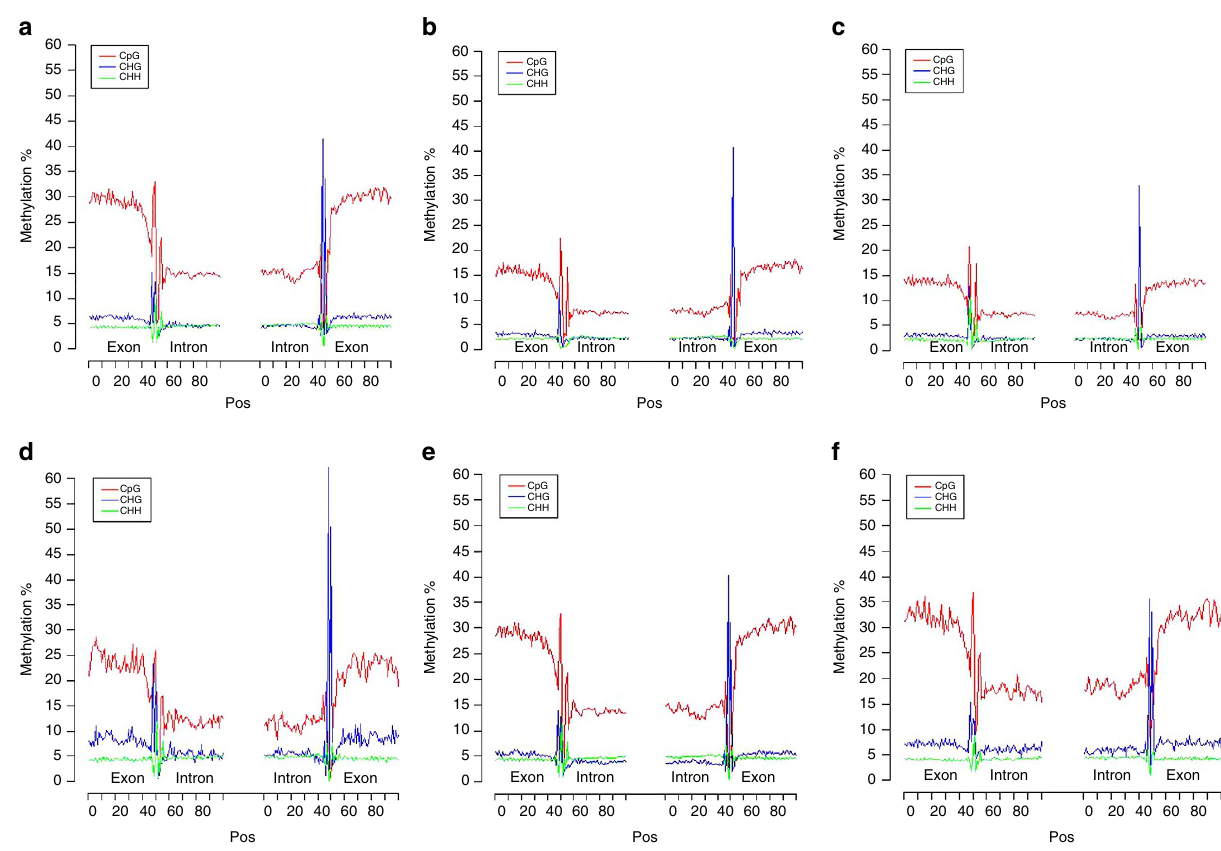
Figure 6 | Level of DNA methylation at splice sites. ( a ) Level of DNA methylation, combing sense and antisense strand. ( b ) Level of DNA methylation on the sense strand. ( c ) Level of DNA methylation on the antisense strand. ( d ) Level of DNA methylation in genes with only one isoform. ( e ) Level of DNA methylation in all isoforms of genes with two to ten isoforms. ( f ) Level of DNA methylation in all isoforms of genes with more than 20